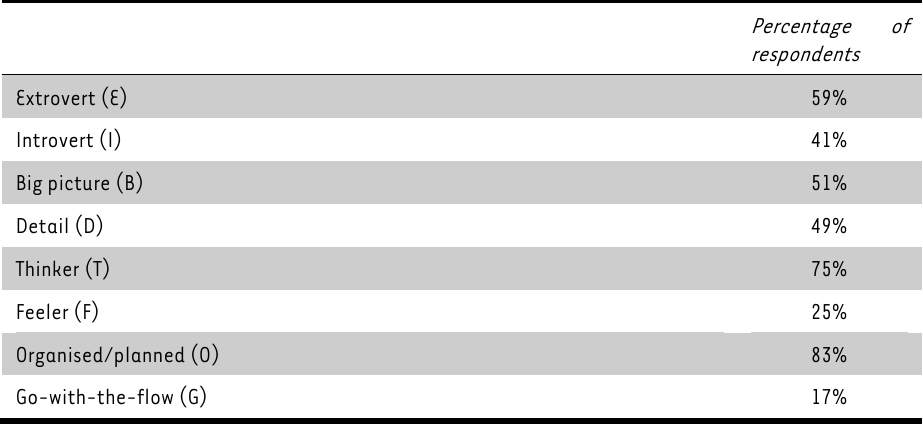
TABLE 1: Reported personality traits